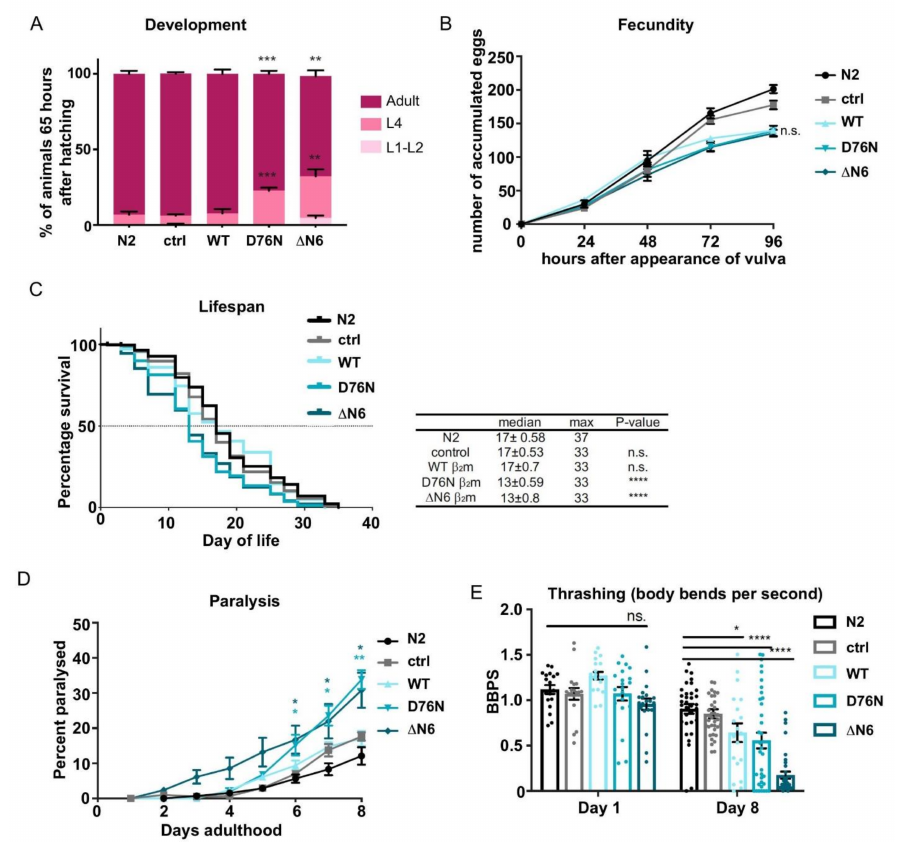
Figure 2. Physiological effects of β 2 m expression on the health of C. elegans . ( A ) Development analysis of β 2 m expressing nematodes compared with N2 and control animals ( myo-2p::mCherry ) 65 h after hatching. Data are expressed as the percentage of nematodes on the plate at each developmental stage (L2, L4 and adult stage). Three independent experiments were performed ( n = 100 animals per experiment). ** p < 0.01; *** p < 0.001. ( B ) Fecundity assay analysing the number of eggs laid after 24, 48, 72 and 96 h after the appearance of the vulva. Three independent experiments were performed ( n = 30 animals per experiment). ( C ) Lifespan analysis of WT β 2 m, D76N β 2 m and ∆ N6 β 2 m animals compared with control and N2 animals. The plots are representative of three independent experiments with 80-100 nematodes. A log-rank test was performed to calculate statistical significance (**** p < 0.0001; n.s. = not significant.). The median and maximum lifespan for each strain is listed in the table right to the graph. ( D ) Paralysis assay of C. elegans expressing WT β 2 m, D76N ◦ C. The data represent the S.E.M. of three independent experiments ∆ N6 β β 2 m and 2 m compared with wild-type (N2) at 20 ( n = 100 animals per experiment). * p < 0.01; ** p < 0.005. ( E ) Thrashing rates of control, WT β 2 m, D76N β 2 m and ∆ N6 β 2 m animals compared with N2 at Day 1 and Day 8 of adulthood. Data represent the SEM of the number of full body bends per second (BBPS) in M9. Three independent experiments were performed ( n = 20 animals). A student’s t test was performed to test significance: ** p < 0.01, **** p < 0.005; n.s. = not